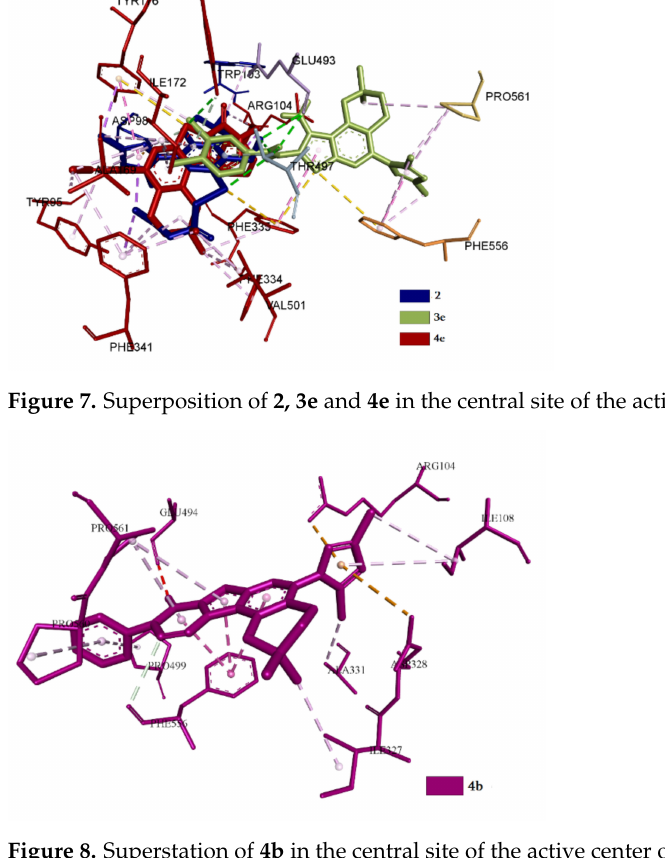
mirrored relative to each other. The difference of root-mean-square deviation (RMSD) is 0.5 Å with an angle of 36 ◦ . Amino acid residues Arg104, Asp328, Ala331 and Phe556